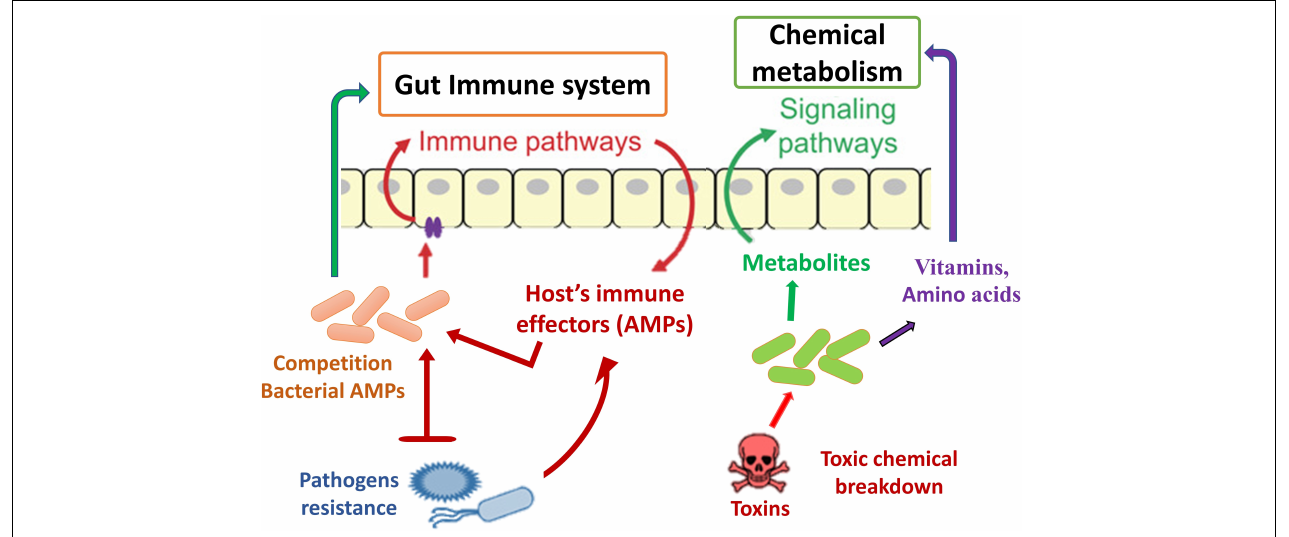
FIGURE 5 | Schematic diagram of the role of gut microbiota in immune and resistance mechanism.